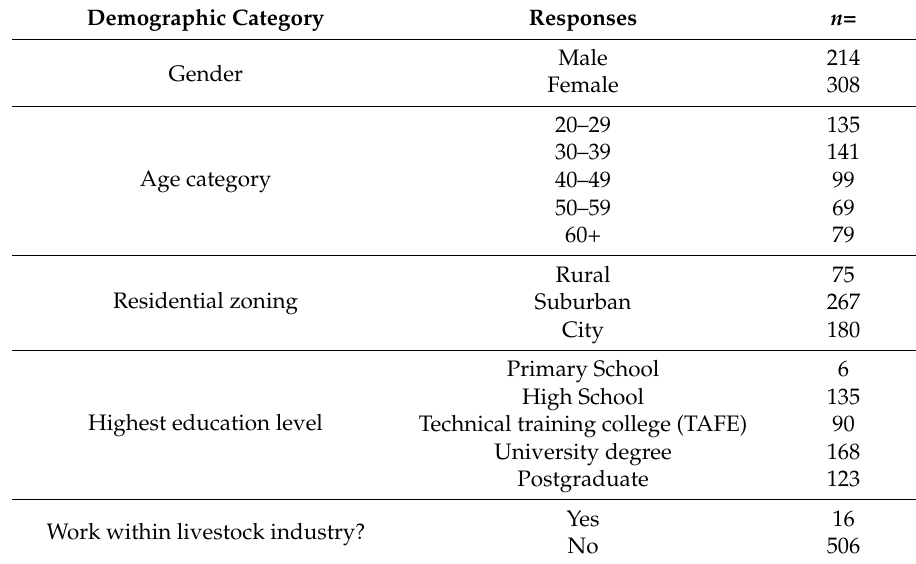
Table 1. Description of participant demographics in respondents ( n = 522) to a survey of public opinion in Brisbane CBD about live export in Australia *.